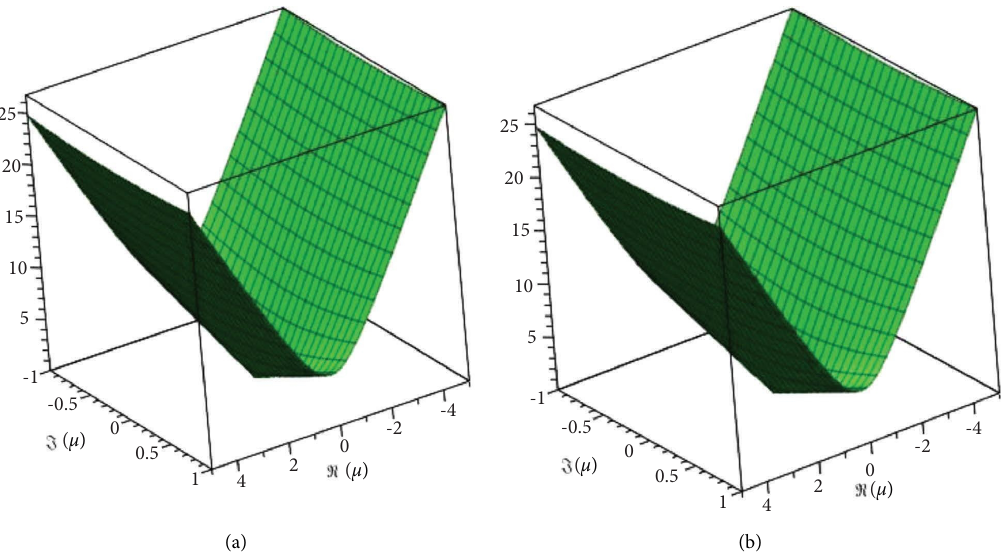
Figure 11: For varying Z and η values, the number of death cases are increases fastly (a) H